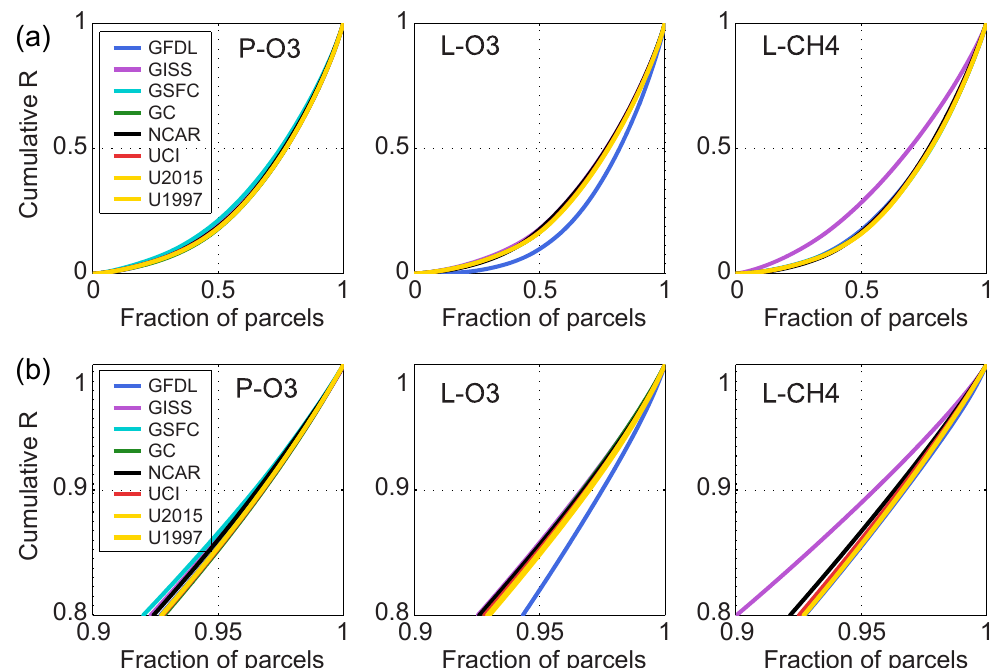
Figure 4. Cumulative reactivity of the 14880 parcels (equally weighted) scaled to the average of each model and reactivity. The lower panel shows a blowup of the top 20% (Cumulative = 0.8 to 1.0). Results for the 6 models plus two different years for UCI are shown.